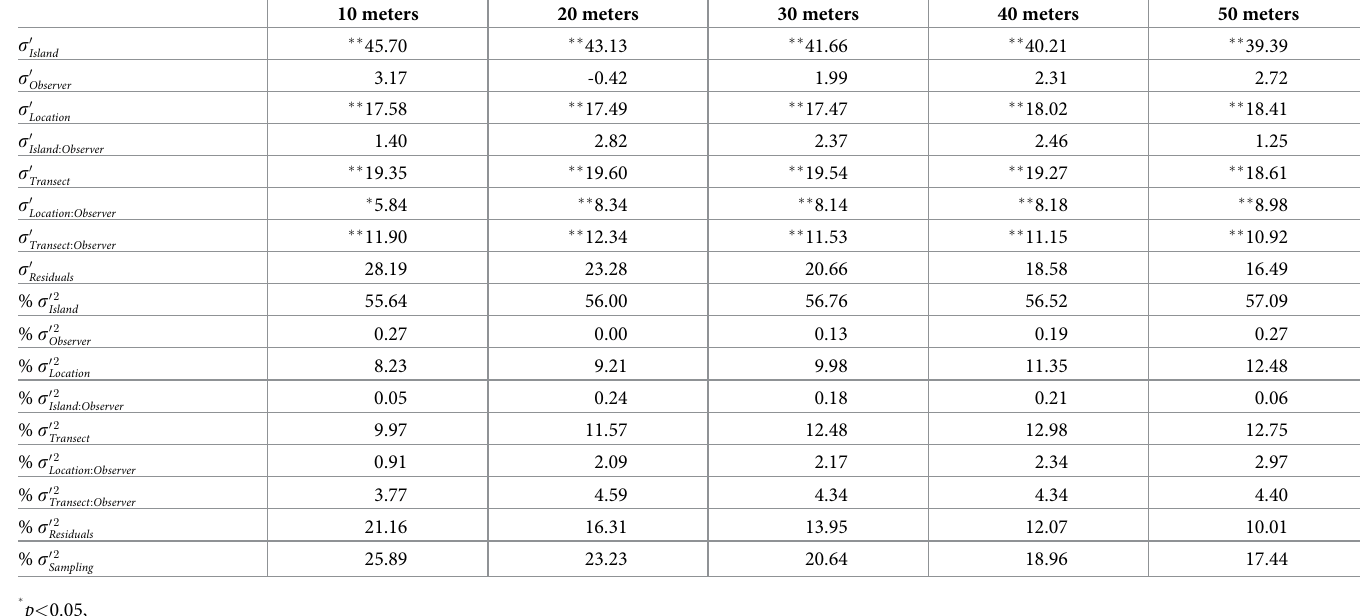
Table 4. Multivariate variation of the fish assemblage structure. Square root estimates of components of variation ( s 0 ) and the percentage of variation of each compo- nent to the total variation of PERMANOVA models based on Bray-Curtis dissimilarities (fourth-root transformed) with Island as fixed factor, Location and Transect as nested random factors and Observer as crossed random factor for transect lengths of 10, 20, 30, 40 and 50 meters.